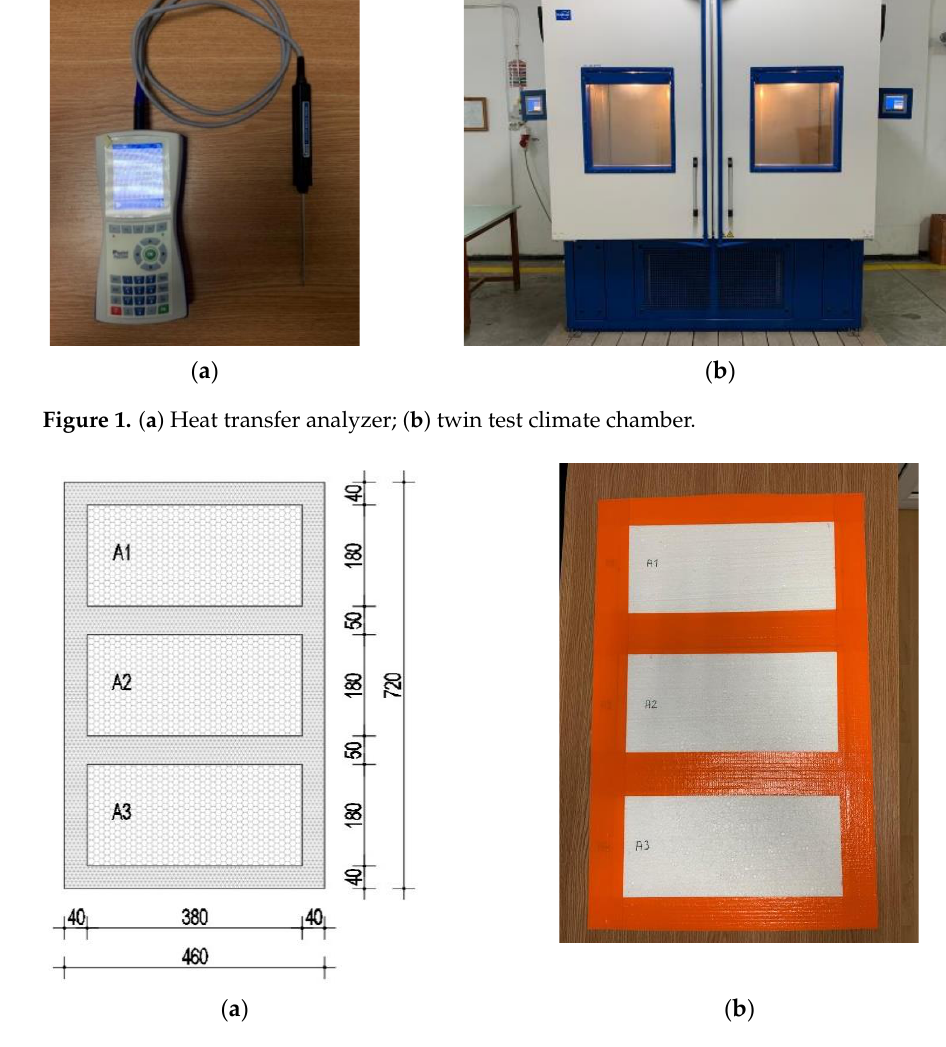
Figure 1. ( a ) Heat transfer analyzer; ( b ) twin test climate chamber.